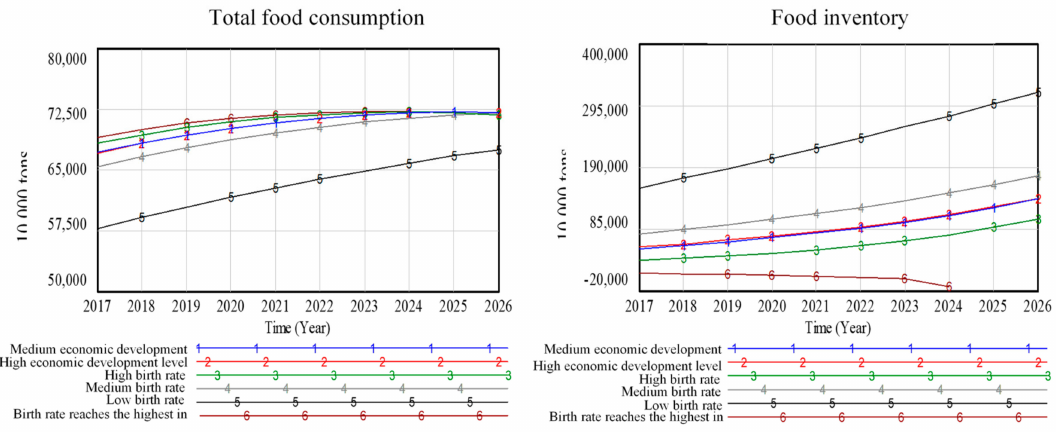
Figure 9. Scenario prediction curve of food